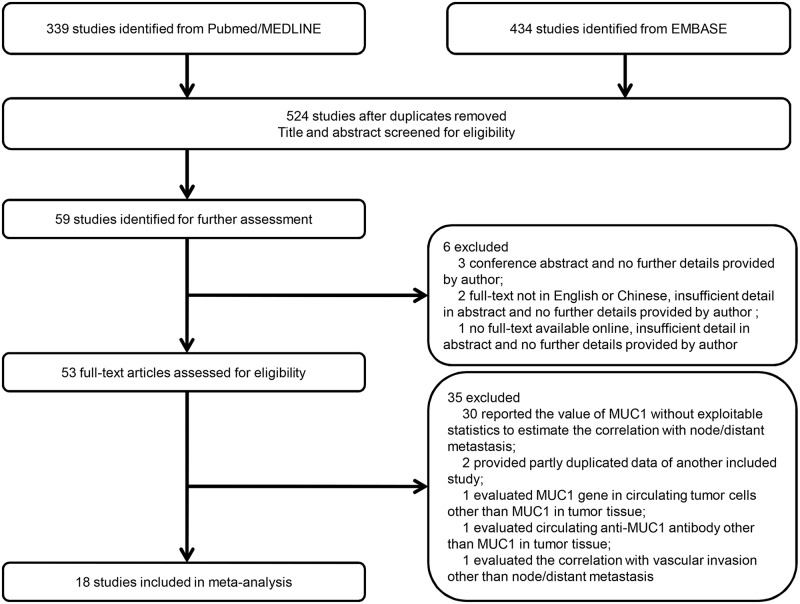
Flow diagram showing inclusion and exclusion of studies.